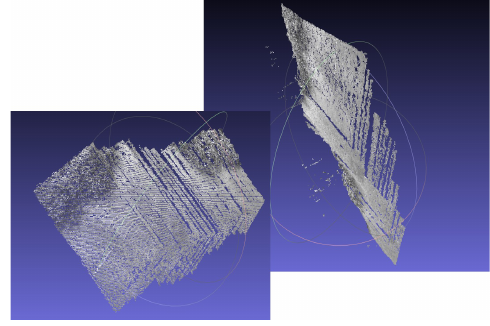
Figure 3. Depth Map (Left) and 3D Point Cloud Model (Right) of the Disaster Site